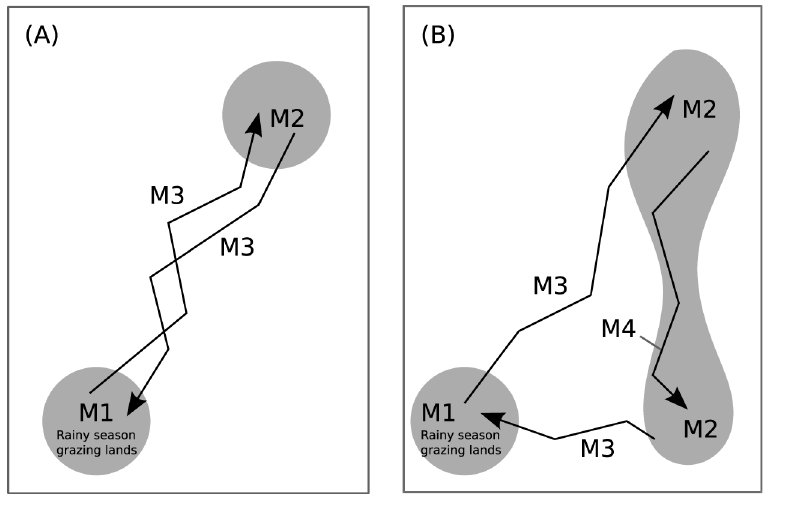
Fig 5. Transhumance modes for pastoralists in groups 1 and 2 (A) and group 3